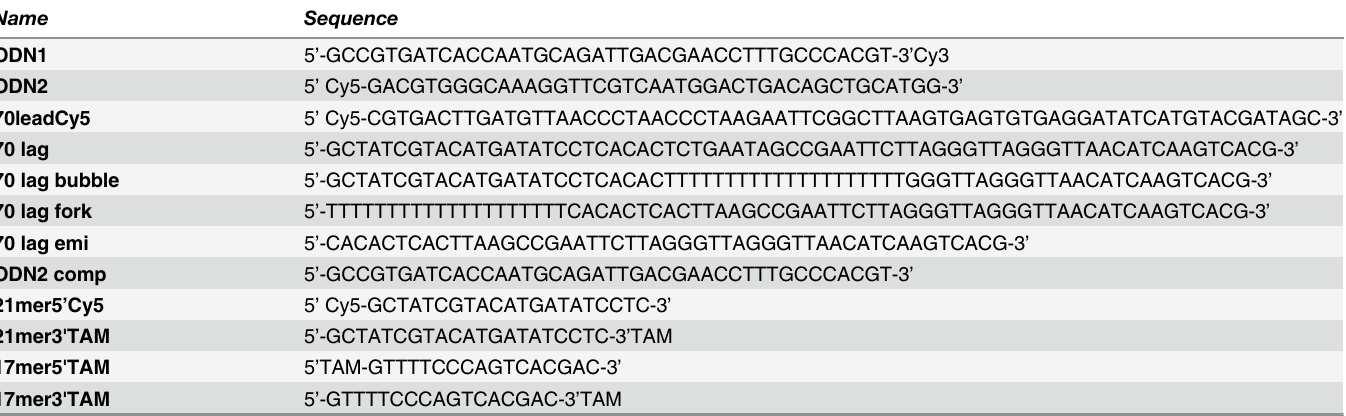
Table 1. Oligonucleotides used for DNA substrates preparation.